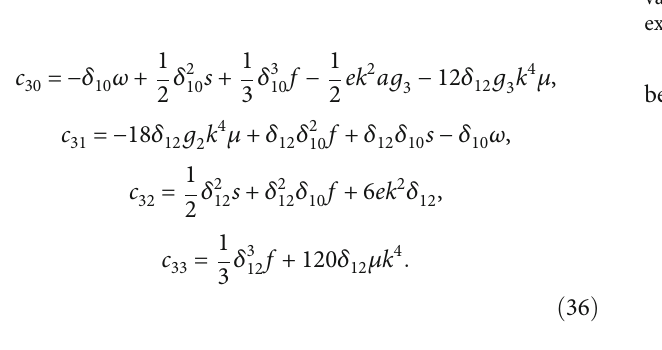
ð z Þ for the fi xed s ,1